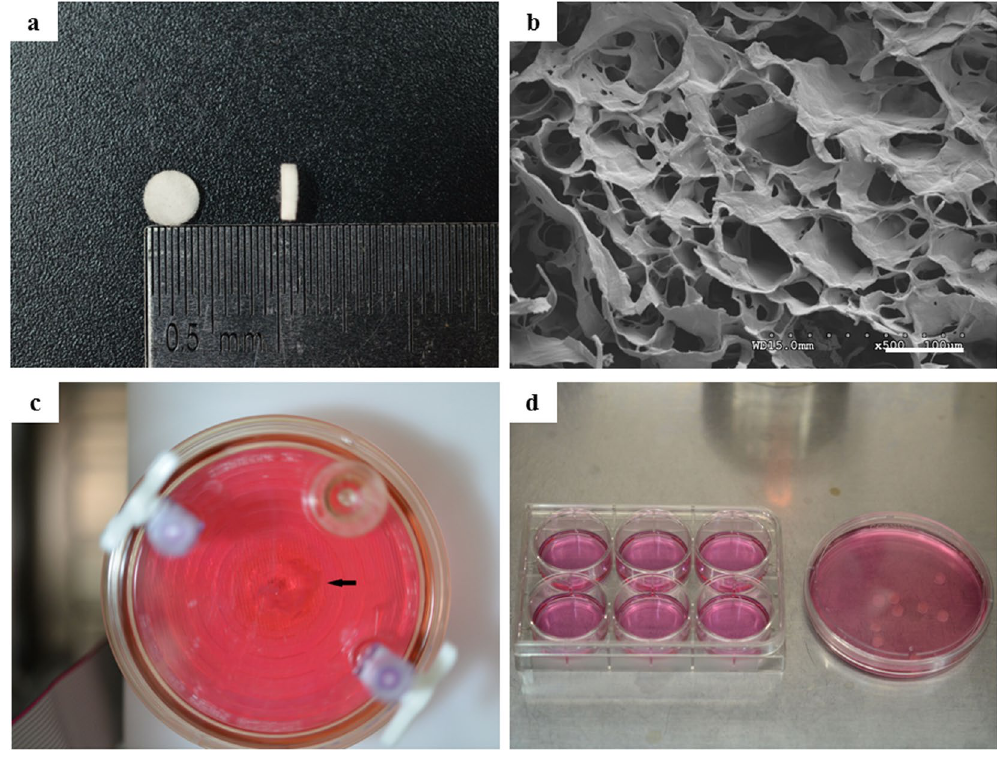
Figure 2. The morphology of BMSCs on 2D culture plate and 3D scaffolds. ( a ) Macrophotograph of 3D collagen porous scaffolds. ( b ) SEM image of 3D porous scaffolds. Scale bar = 400 μ m. ( c ) Macrophotograph of BMSCs cultured in RCCS-3D group. ( d ) Macrophotograph of BMSCs cultured in static-2D group and static-3D